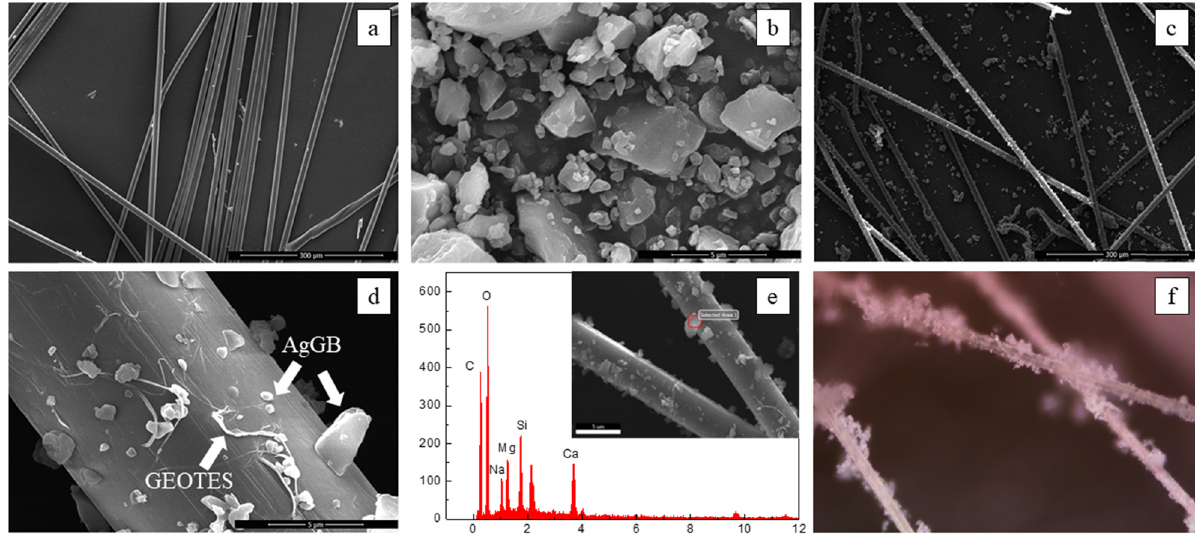
Figure 2: SEM images of ( a ) pristine AF, ( b ) AgGB particles, ( c ) AgGB@AF, ( d ) AgGB@AF in partially enlarged view, ( e ) EDS image of AgGB@AF, and ( f ) optical microscope image of